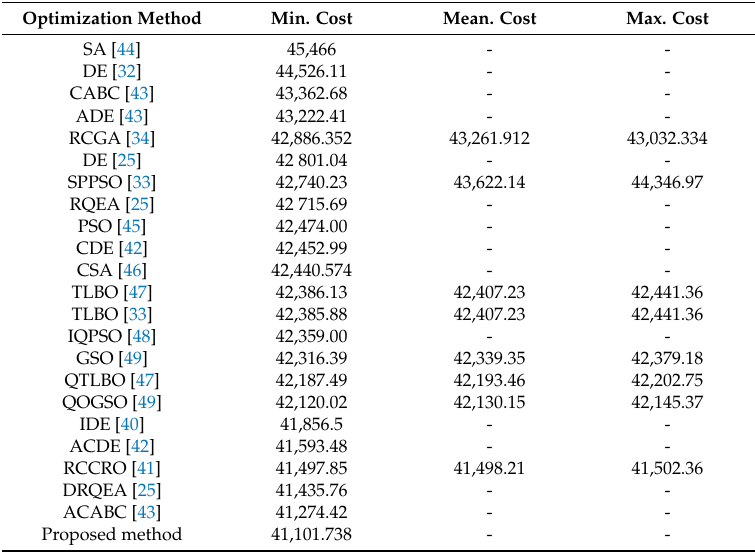
Table 6. Comparison of obtained optimal costs for test system 2 case